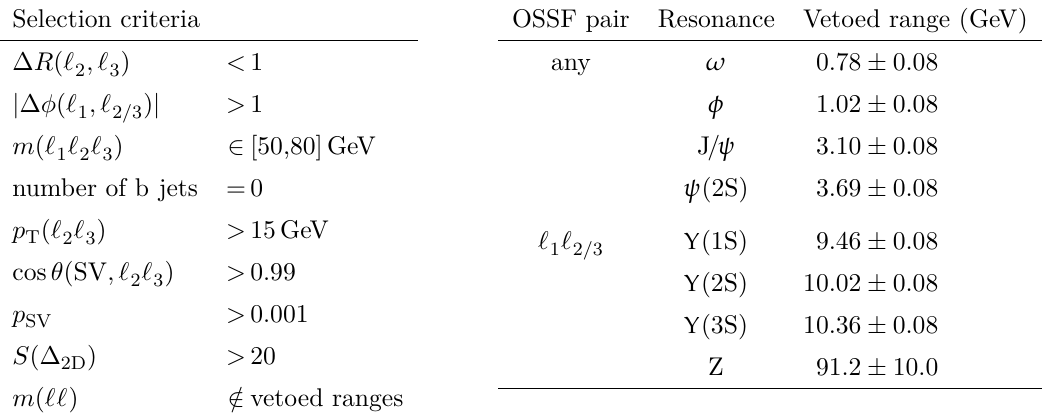
Table 1 . Baseline selection criteria (left) and dilepton invariant mass vetoes (right) applied in the analysis. The width of the vetoed range for the meson resonances reflects the experimental resolution of the dilepton invariant mass